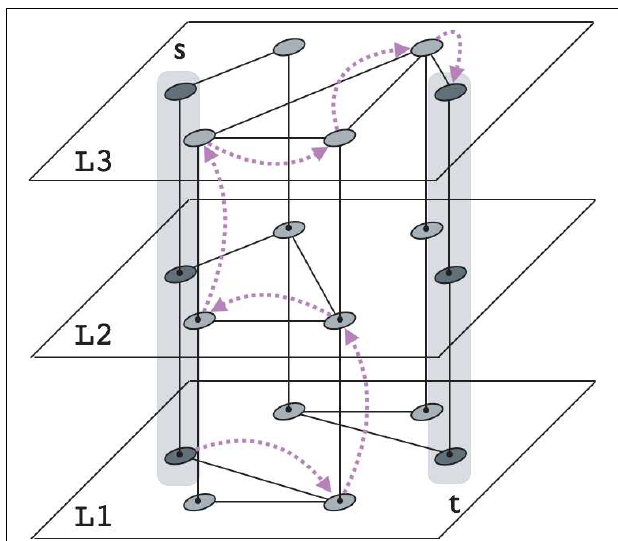
FIGURE 1 | Example of a walk (dotted trajectory) between two individuals s and t using a multilayer network. The walker can jump between nodes within the same layer, or it might switch to another layer. This illustration evidences how multilayer structure allows a walker to move between nodes that belong to different (disconnected) components on a given layer